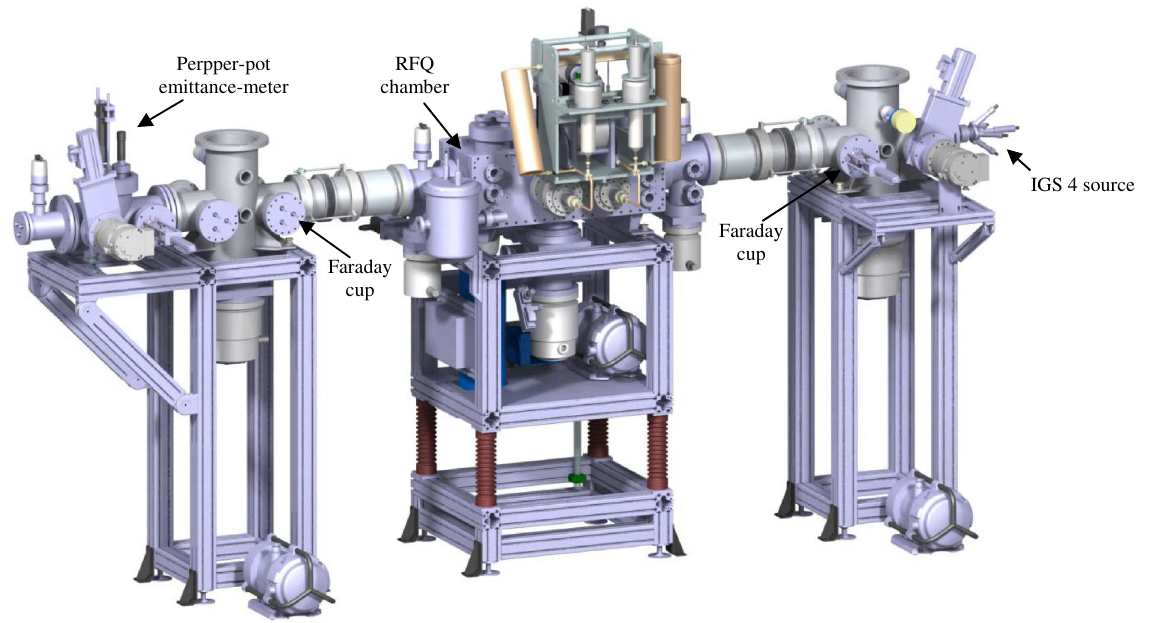
FIG. 6. 3D schematic of the planned test setup for the SHIRaC prototype.